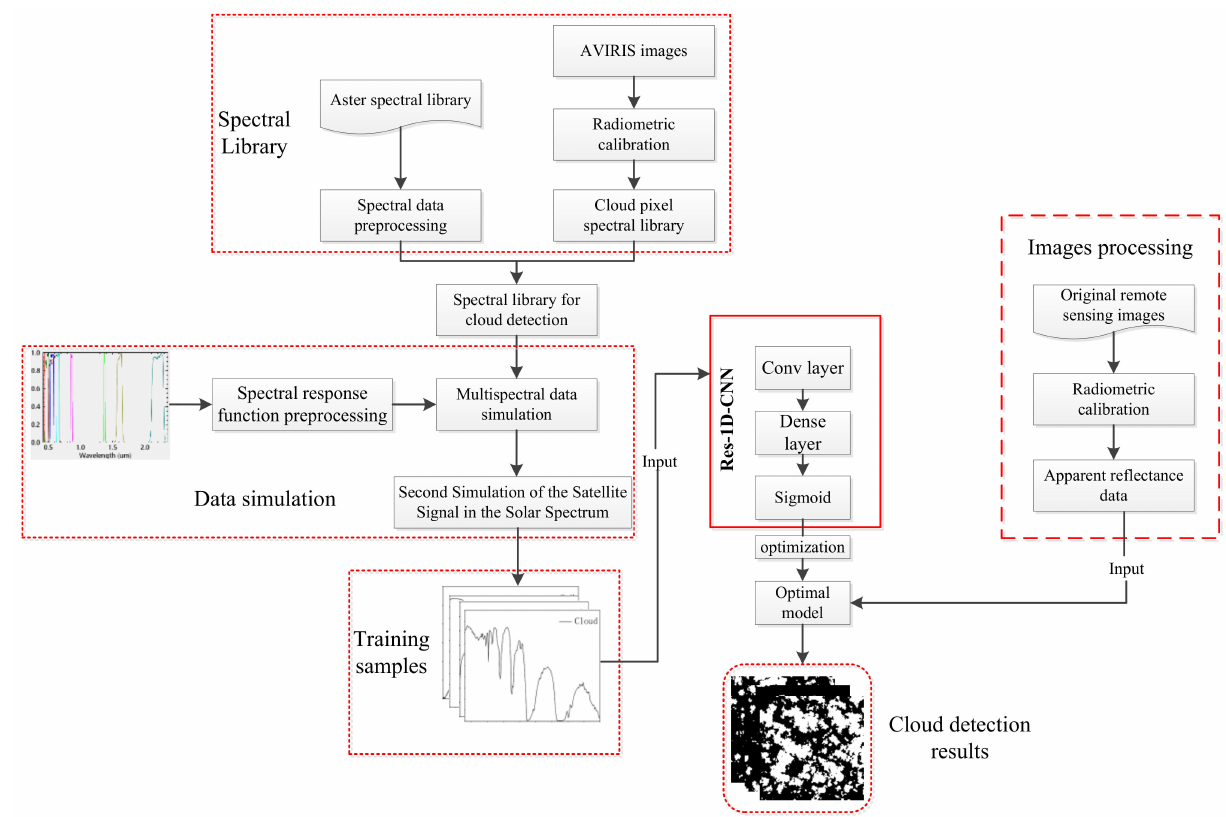
Figure 1. Framework of the cloud detection algorithm based on a spectral library and a convolutional neural network (CD-SLCNN